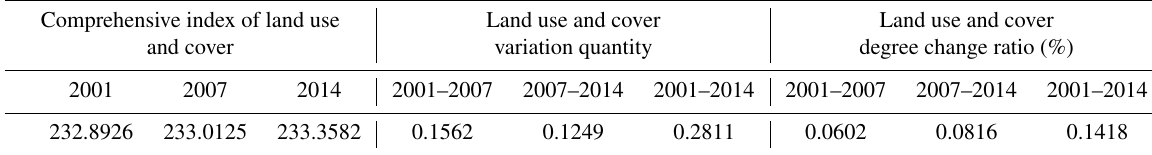
Table 2. Land use and cover comprehensive index, variation and change rate in the Qiantang River basin. Comprehensive index of land use